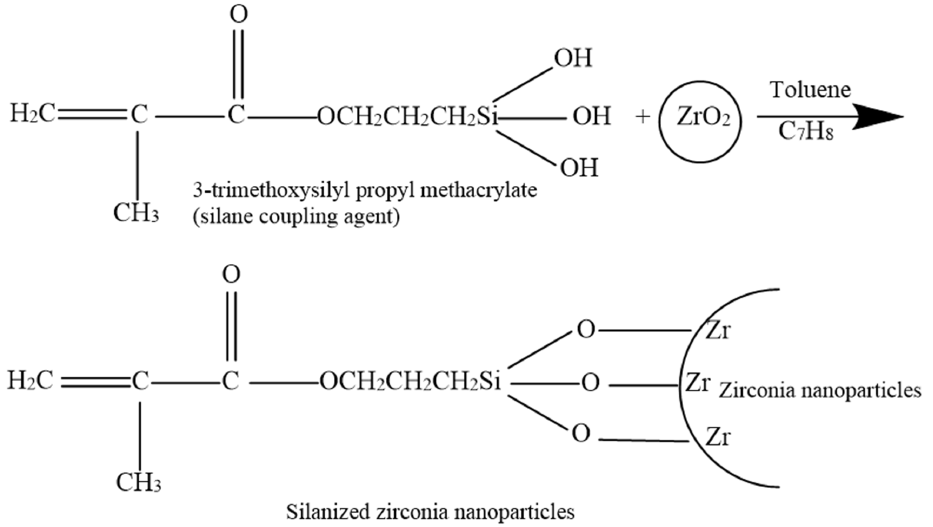
Figure 4. Illustration showing the chemical bonding of silane ( γ -MPS) with zirconia (ZrO 2 ) nanoparticles.